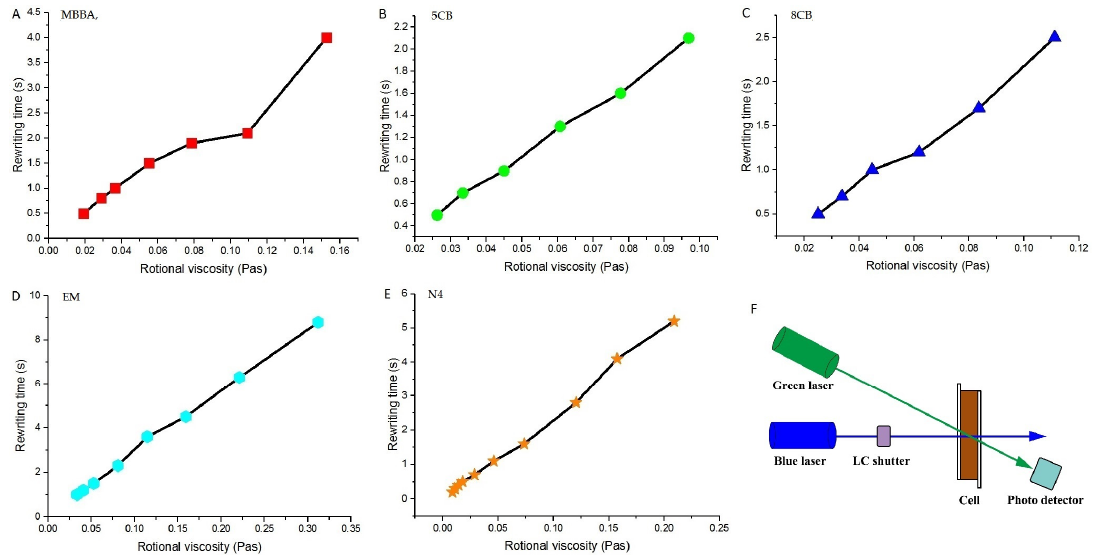
Figure 3. ( A )–( E )The rewriting time as the function of rotational viscosity for the five di ff erent kinds of the LCs respectively (MBBA, 5CB, 8CB, EM and N4) ( F ) Experimental arrangement for the rewriting time measurement of the ODLCD samples.